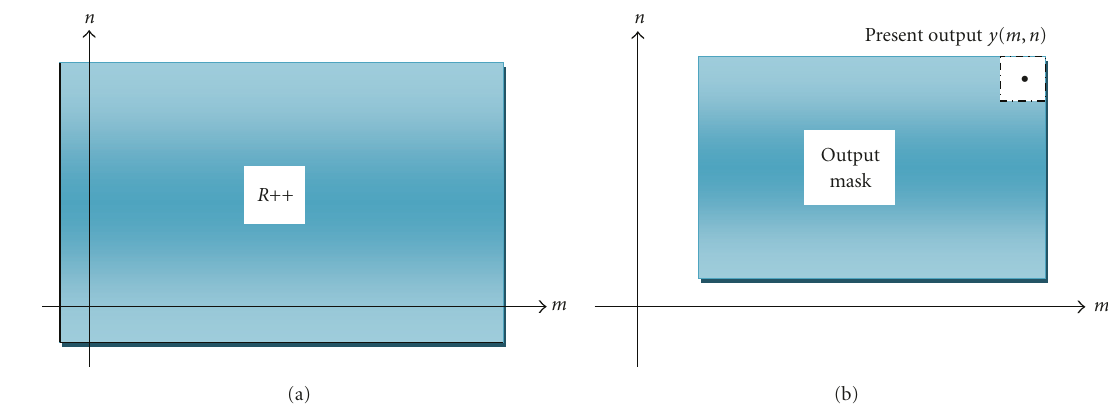
Figure 1: (a) The ++ Quarter-Plane. (b) 2D recursion Using ++ Filter.